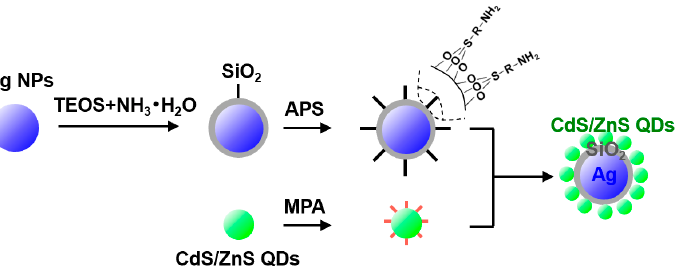
Figure 1. Schematic diagram of preparing Ag@SiO 2 @CdS/ZnS QD composite